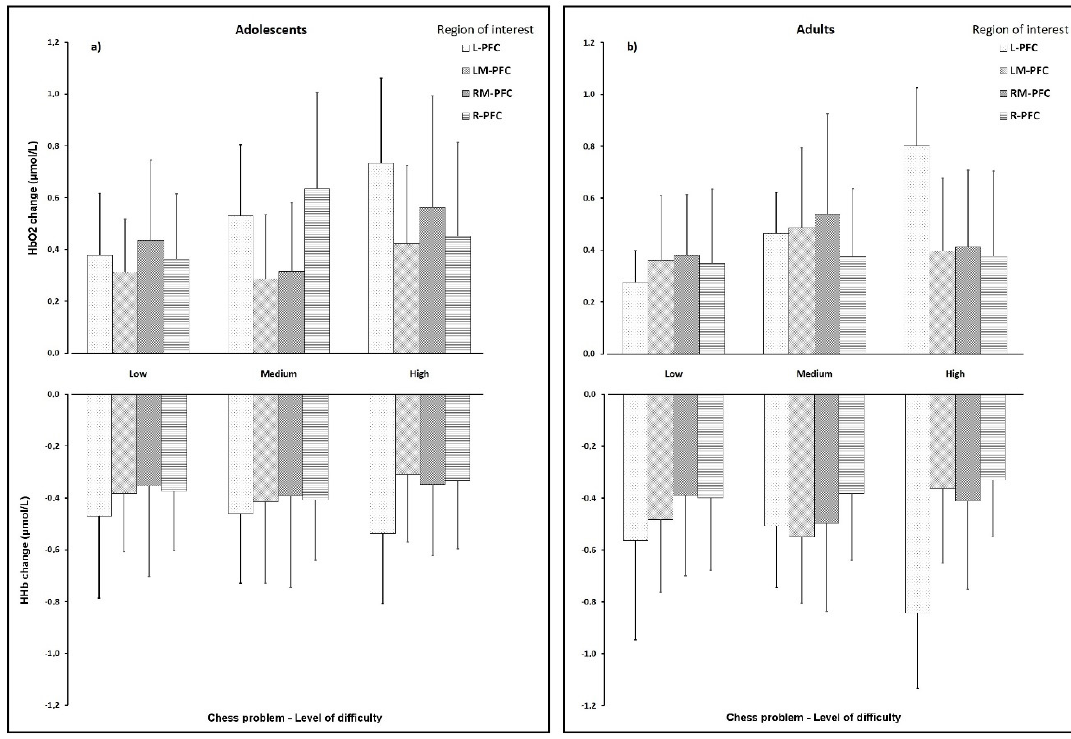
Figure 3. Relative changes in oxygenated hemoglobin (HbO2) and deoxygenated hemoglobin (HHb) in the adolescents group (( a ) panel) and in the adults group (( b ) panel), according to the level of di ffi culty of the chess-based problem-solving tasks. L-PFC—left prefrontal cortex; R-PFC—right prefrontal cortex; LM-PFC—left medial prefrontal cortex; RM-PFC—right medial prefrontal cortex.